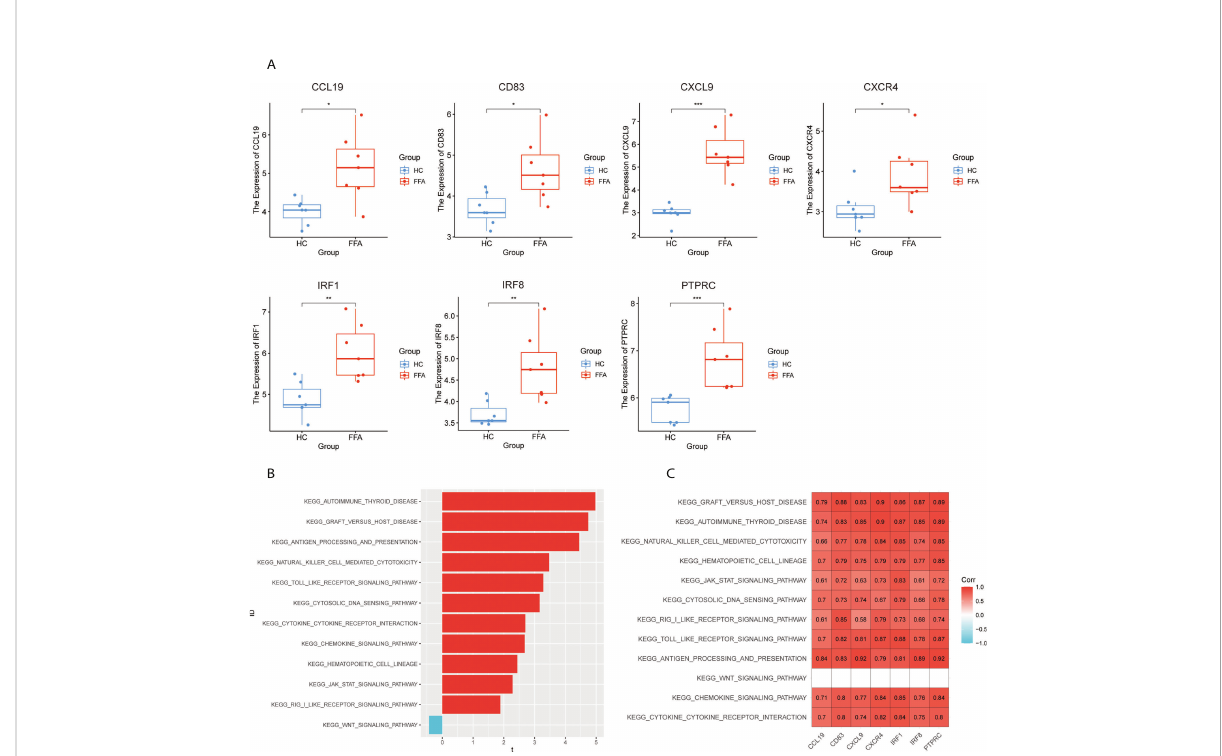
FIGURE 7 Validation of hub genes: (A) expression levels of hub genes in GSE125733, *p < 0.05, **p < 0.01, ***p < 0.001, ****p < 0.0001, (B) T-statistic of the GSVA scores in common GSEA pathways, and (C) correlation heat map between the expression levels of hub genes and GSVA scores of the common pathways in GSE125733. GSVA, gene set variation analysis; GSEA, gene set enrichment analysis.